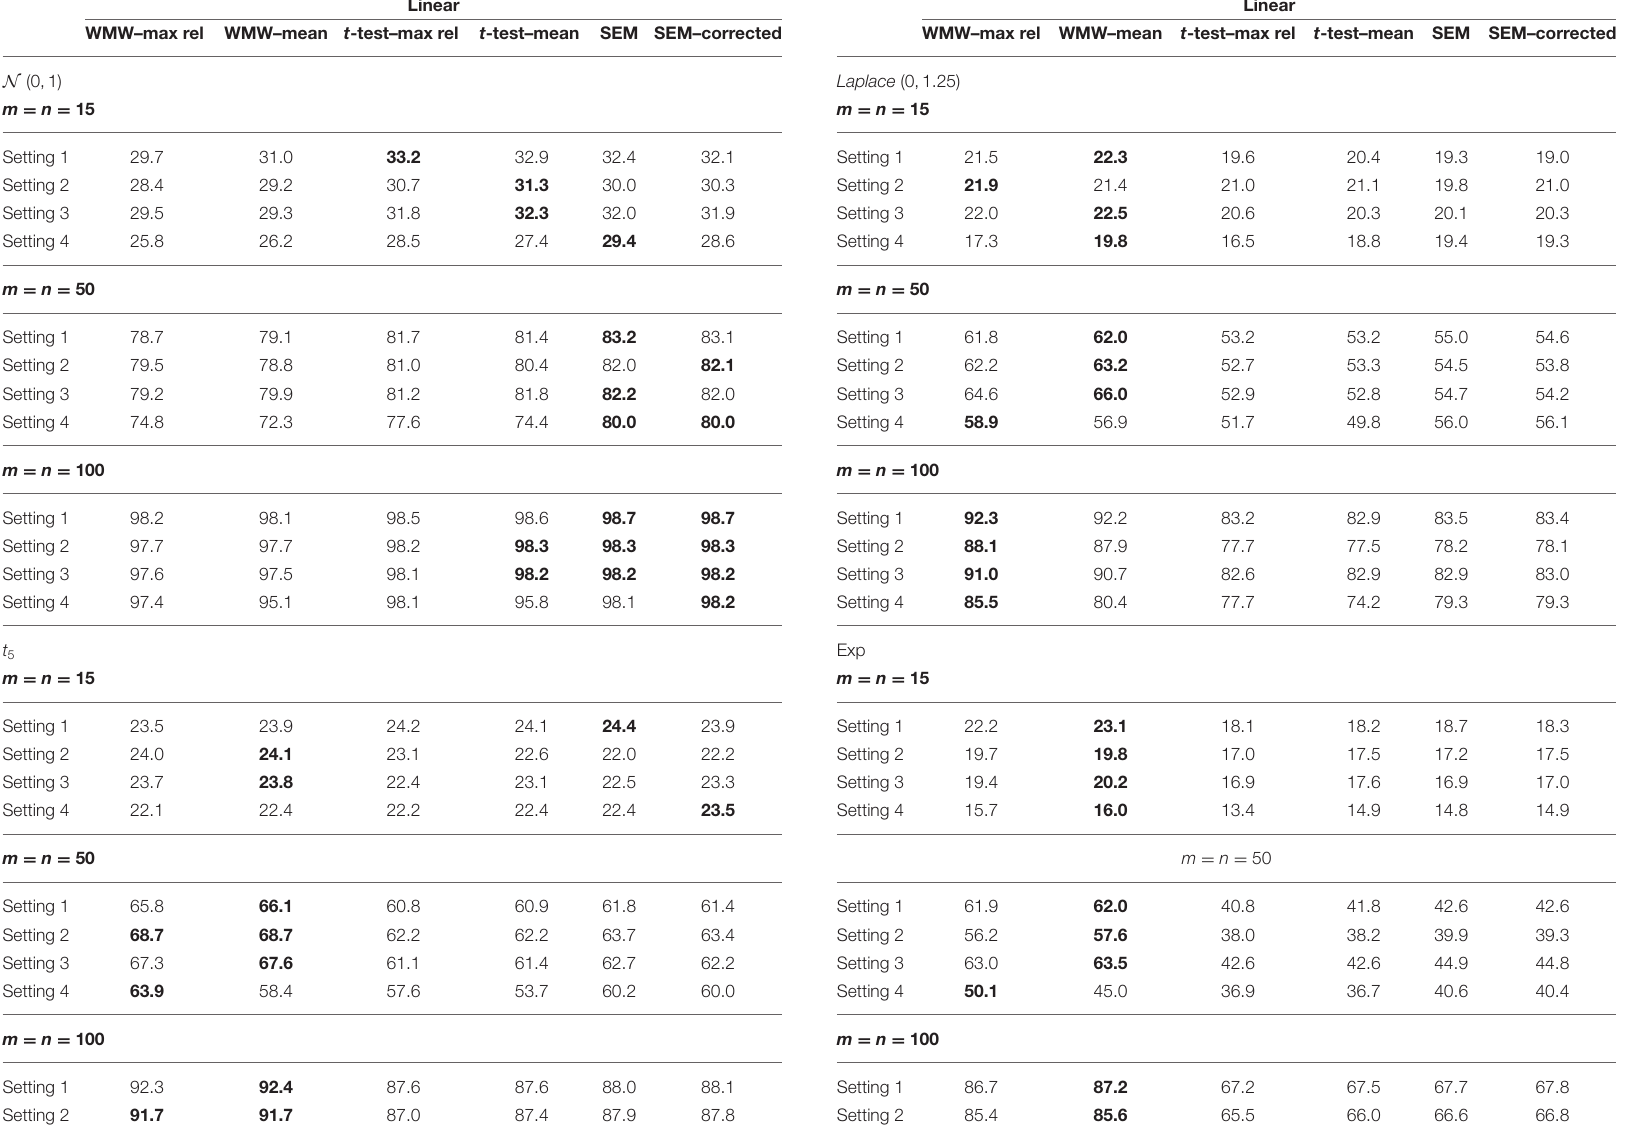
TABLE 1 | Empirical power from the simulation study with the indicators having an overall reliability of 80% and a linear relationship with the latent variable. Linear